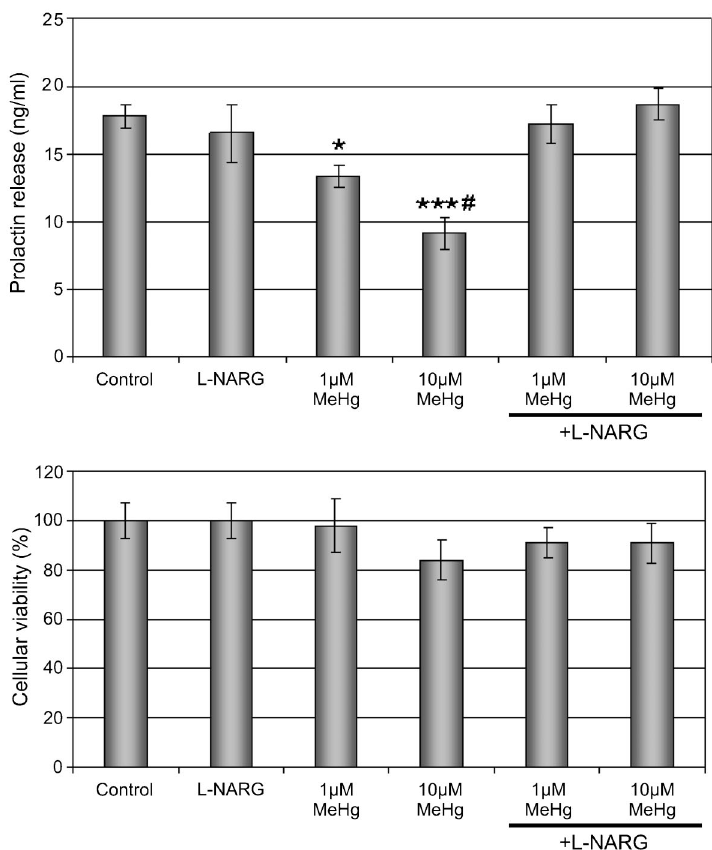
Figure 3. Prolactin release ( top panel ) and cellular viability ( bottom panel ) of the rat pituitary cell line GH3B6 exposed to different methylmer- cury (MeHg) concentrations and/or 3 mM N- nitro-L-arginine (L-NARG) for 6 h. Data are reported as means ± SE (n=6). *P , 0.05 and ***P , 0.001 vs control and groups incubated with L-NARG and MeHg ++ L-NARG; # P , 0.05 vs 1- m M group (ANOVA with Tukey’s